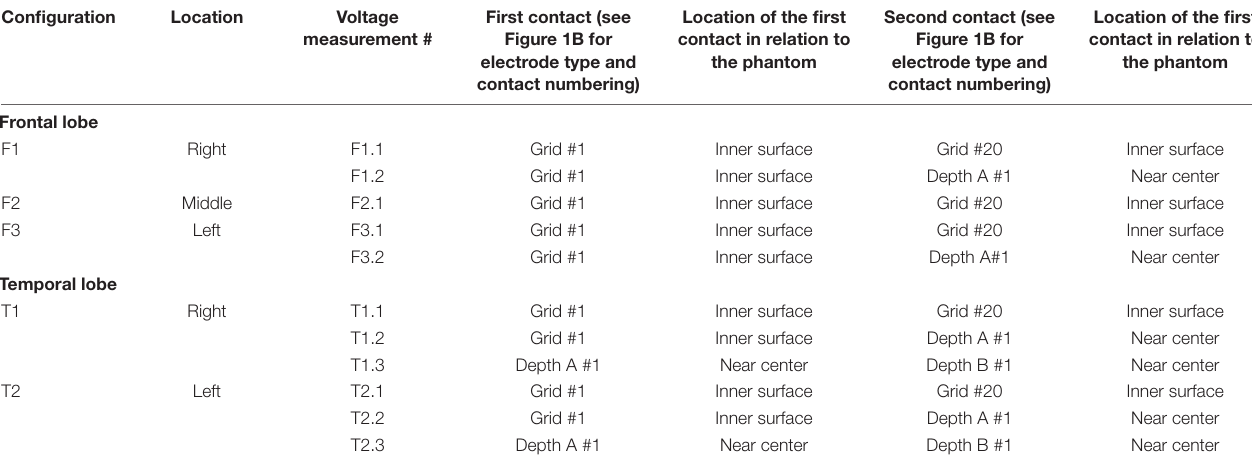
TABLE 4 | Electrode configurations for voltage measurement.